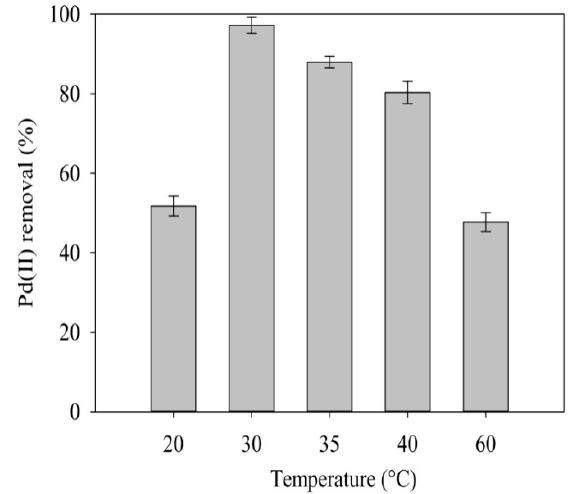
Figure 3. Pd(II) removal under different temperatures at initial Pd(II) concentration of 100 mg/L and experimental time of 10 h.